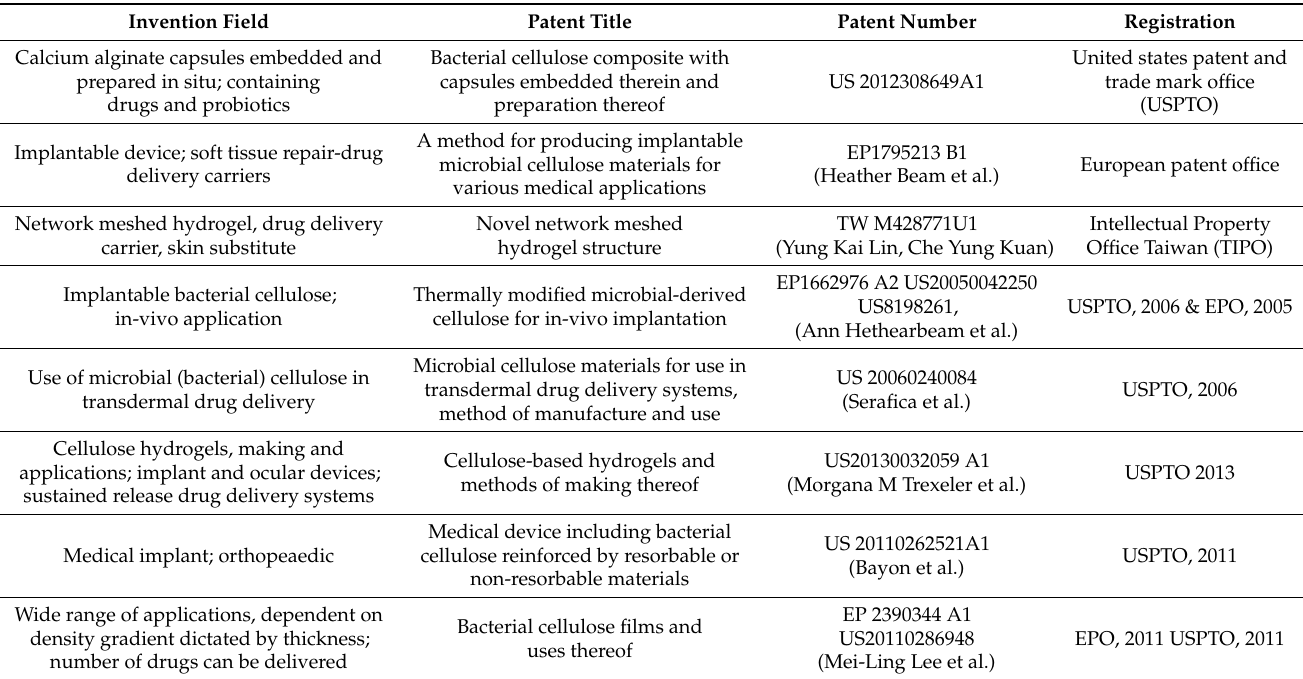
Table 2. Drug delivery patents on BC